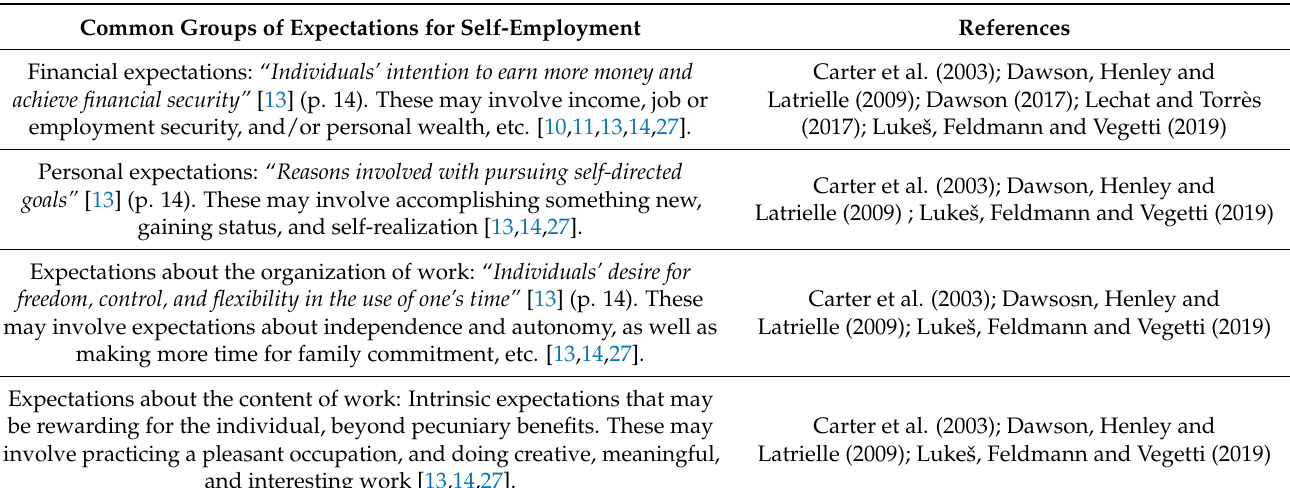
Table 2. Common expectations of self-employment from the